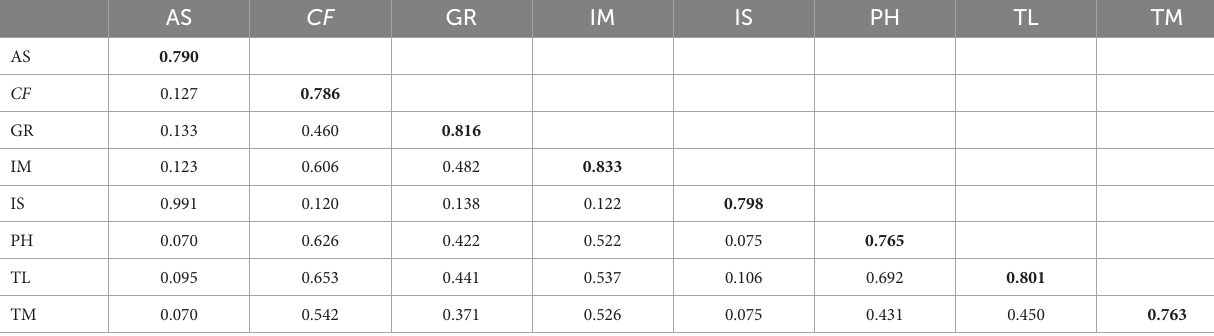
TABLE 3 The results of fornell-larcker